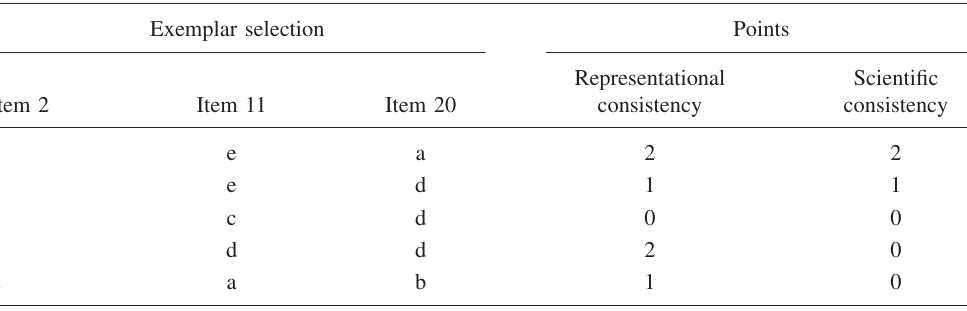
TABLE IX. Examples regarding the grading system for consistency for theme